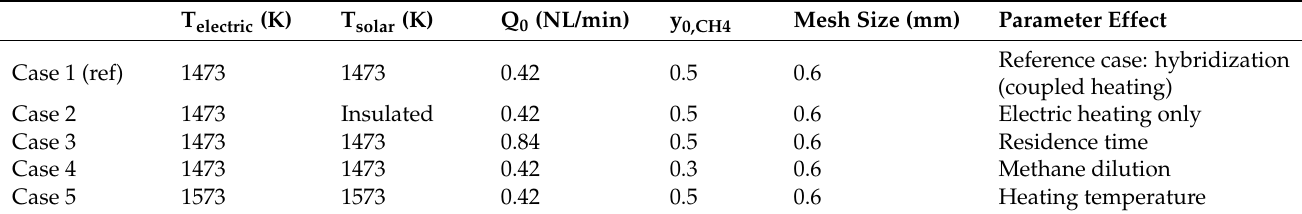
Table 1. Operating conditions simulated through ANSYS